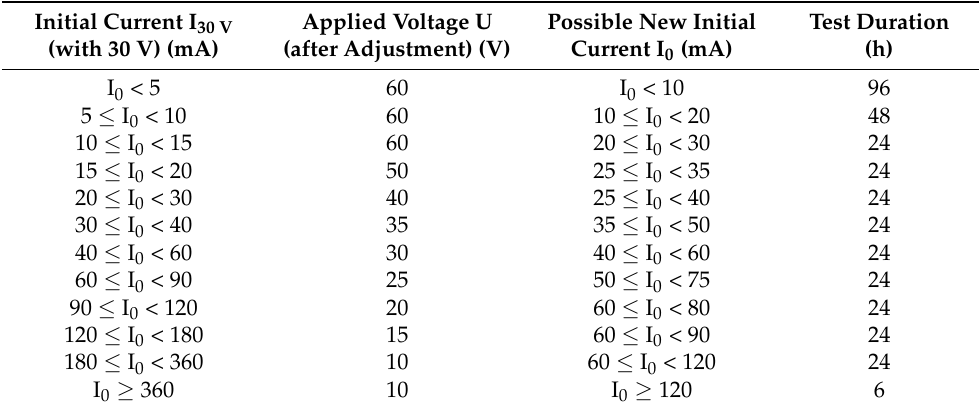
Table 4. Test voltage and duration for the concrete specimen with the normal binder content